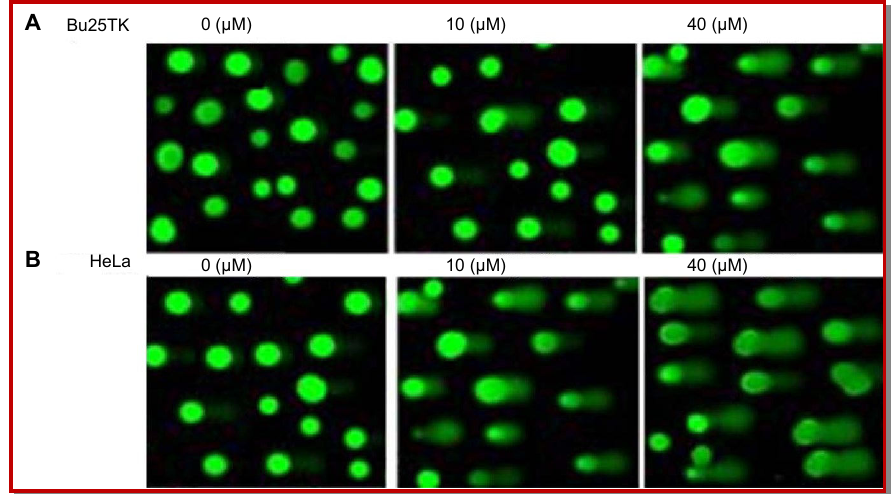
Figure 4: Analysis of DNA degradation in Bu25TK and HeLa cells by comet assay. The images of the cells were captured at a mag- nification of x200. The cells were treated with 40 µM concentration of plumericin for 48 and N - methyl - N - nitro - N - nitrosoguanidin was taken as the control